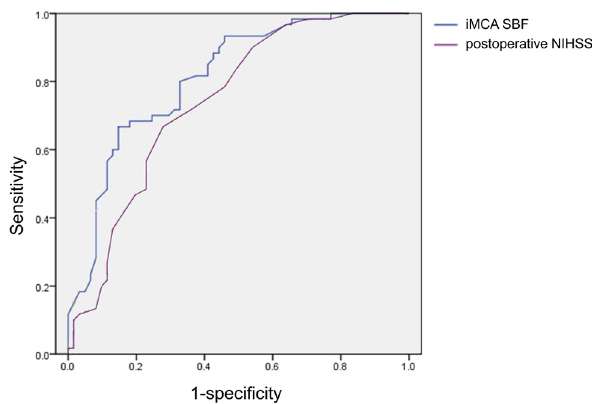
Figure 3: Predictive ability of the ipsilateral middle cerebral artery ( iMCA ) systolic blood fl ow ( SBF ) and preoperative NIHSS score for a good outcome ( 90 - day mRS score ≤ 2 )